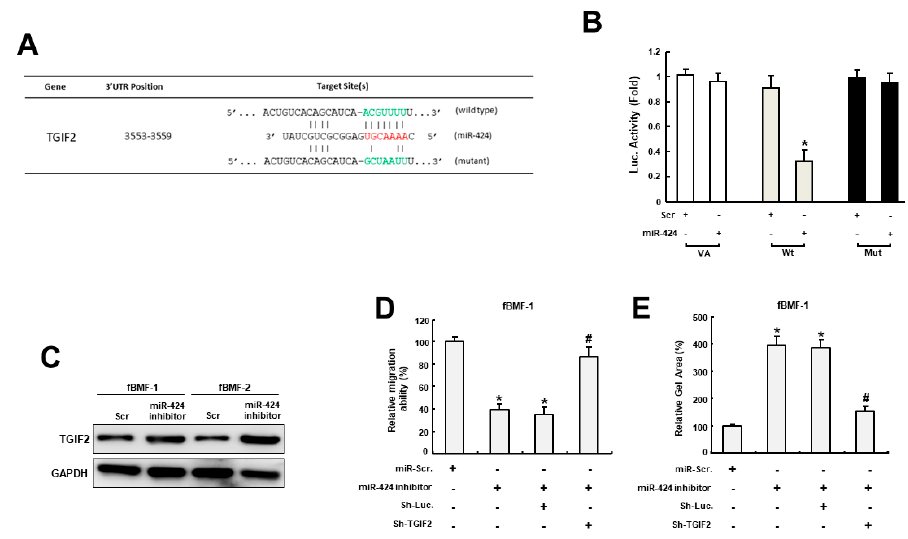
Figure 4. MiR-424 mediates myofibroblast activities via direct binding to TGIF2. ( A ) An illustration of the three prime untranslated regions (3 ′ -UTR) of full-length (wild type) and mutated TGIF2 complementarity between the seed sequence of miR-424 predicted by the TargetScan in silico browser. ( B ) The luciferase activity of the reporter construct containing the wild-type TGIF2 3 ′ -UTR was repressed by miR-424, whereas there was no effect on the activity of reporter constructs containing mutant TGIF2 3 ′ -UTR in BMFs. ( C ) The expression of TGIF2 was upregulated in fBMFs with miR-424 inhibitors. The effects of the miR-424 inhibitor on migration capacity ( D ) and collagen gel contractility ( E ) were reversed in fBMFs when the expression of TGIF2 was reduced. * p < 0.05 compared to miR-Scr. group; # p < 0.05 compared to miR-424 inhibitor+Sh-Luc. group.